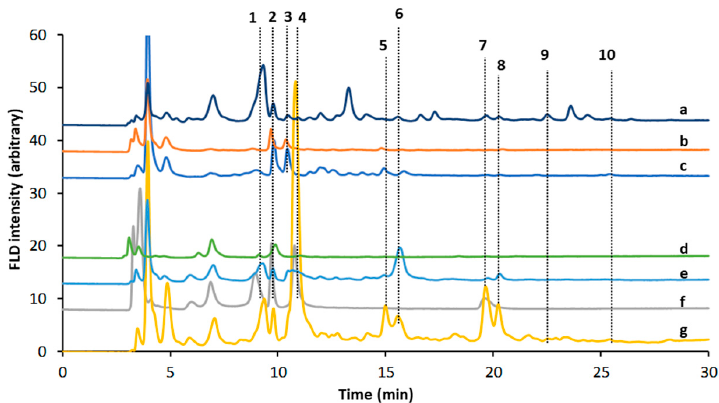
Figure 4. Representative chromatograms of various nutraceutical samples obtained by HILIC-FLD. Sample assignation: a = antioxidant extract; b = cranberry; c = cranberry (combined); d = artichoke; e = red grape (peel and seeds); f = raspberry; g = grapevine. Compound assignation: 1 = catechin; 2 = epicatechin; 3 = procyanidin A2; 4 = procyanidin B2; 5 = trimer 1; 6 = procyanidin C1; 7 = tetramer 1; 8 = tetramer 2; 9 = pentamers; 10 = hexamers (adapted from reference [75]).